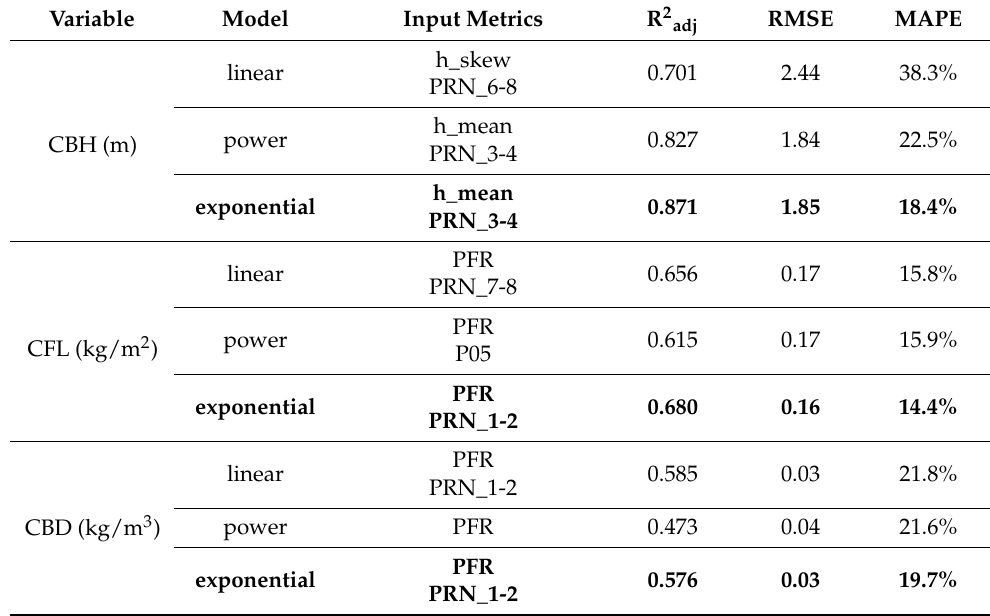
Table 4. Summary of the best canopy fuel models fitted for each formulation with PNOA-2018 LiDAR and field data, with the best performing model in bold for each variable. CBH, canopy base height; CFL, canopy fuel load; CBD, canopy bulk density; R 2 adj , adjusted R 2 ; RMSE, root mean square error; MAPE, mean absolute percentage